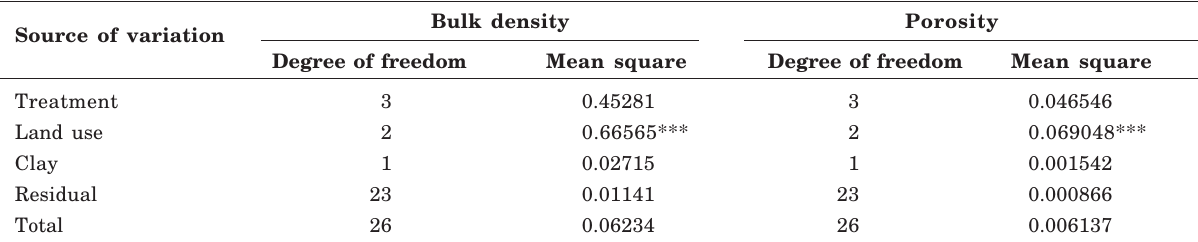
Table 4. Analysis of covariance statistics of soil bulk density and porosity for three land uses (conventional agriculture, no-tillage and native forest) in 0-10 cm